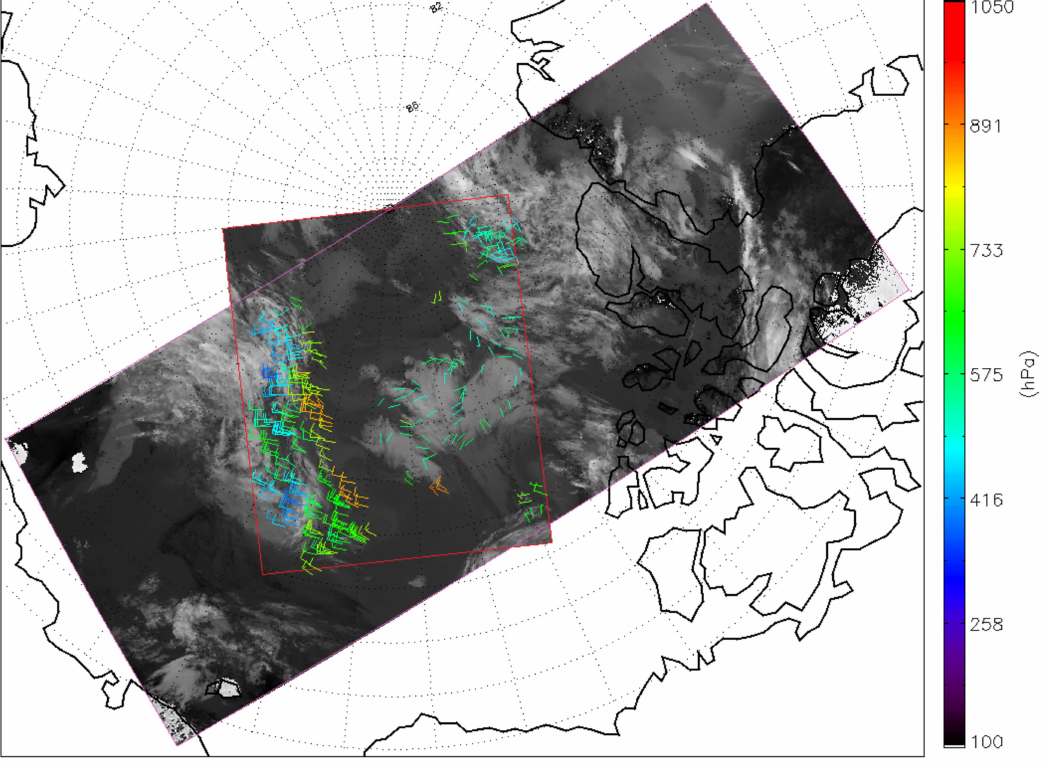
Figure 8. AMVs extracted from SLSTR images taken over the Arctic Ocean on 3 July 2019 at 02:09:49 UTC (red contour) and from 00:25:50 to 00:34:50 UTC (purple